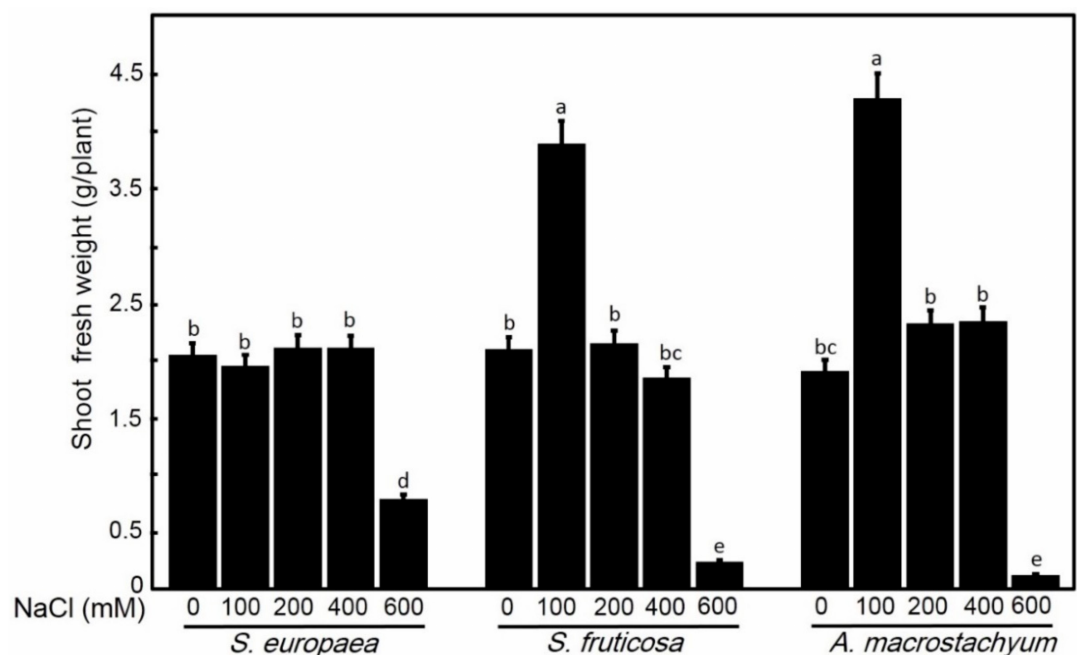
Figure 1. Shoot fresh weights of S. europaea, S. fruticosa and A. macrostachyum under different NaCl concentrations. Mean ± SE of three replicates. Different letters indicate significant differences ( p < 0.05).